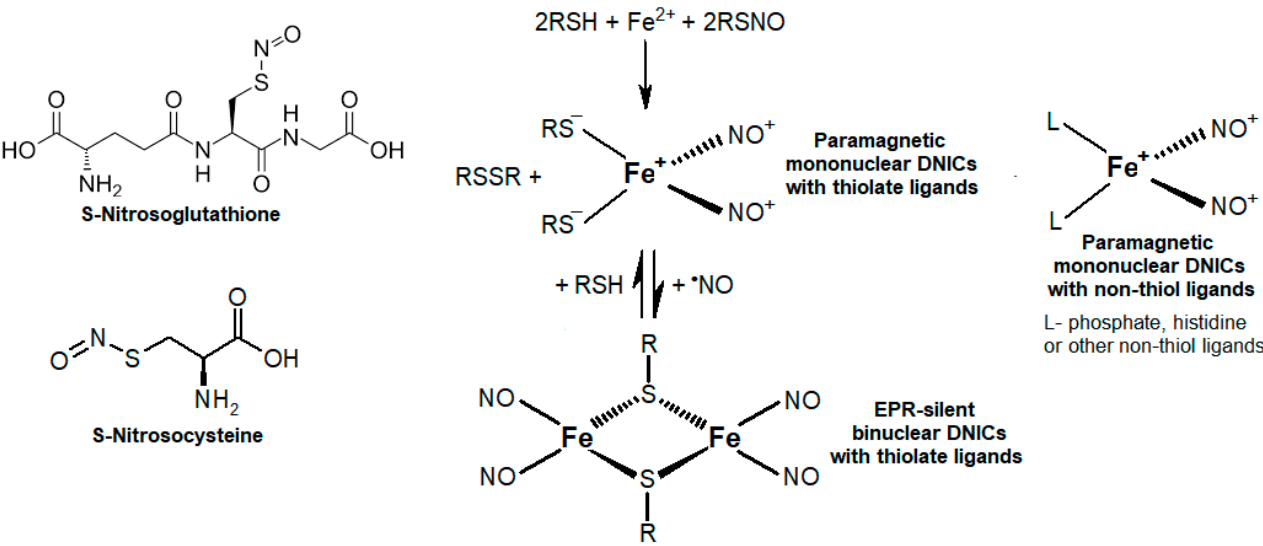
Figure 1. I mportant physiological • NO derivatives. On the left—S-nitrosothiols (RSNOs), on the right—dinitrosyl iron complexes (DNICs) with thiol and non-thiol ligands. right—dinitrosyl iron complexes (DNICs) with thiol and non-thiol Carbonyl stress is accompanied by an increased production of reactive oxygen (ROS)